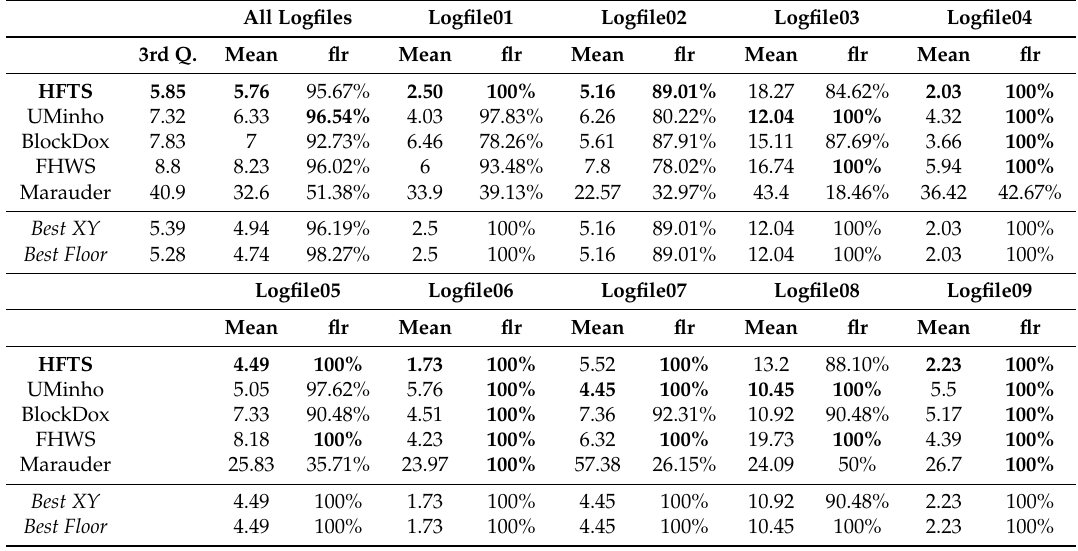
Table 3. Overall results and main statistic value per logfile (best values in bold font). The 3rd quartile and mean errors are in meters, floor hit rates (flr in the table) are in percentage of correct estimates. The values for the ’all logfiles’ column correspond to the mean error and floor hit detection rate of the 578 validations points, and they do not correspond to the average of the nine logfiles. All Logfiles Logfile01 Logfile02 Logfile03 3rd Q.